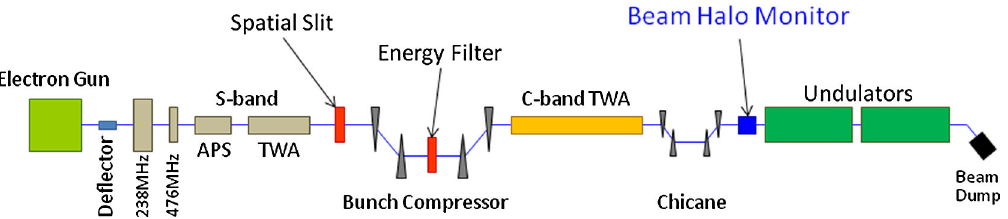
FIG. 7. Layout of SCSS test